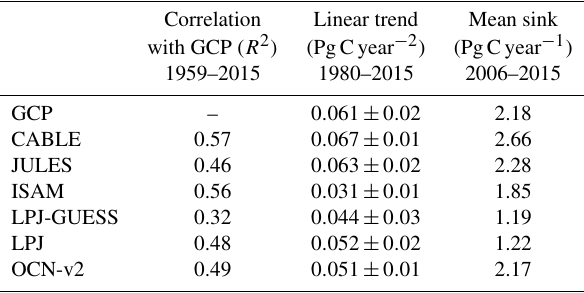
Table 4. Simulated annual time series of the global land carbon sink: correlation with GCP, linear trend and mean